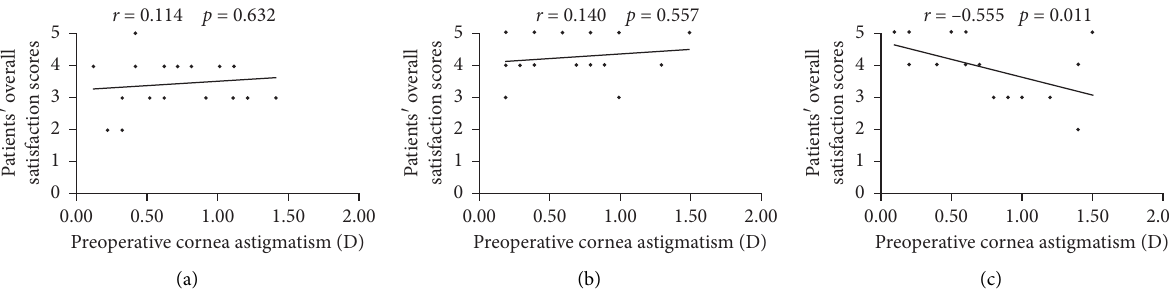
Figure 6: Correlations between the overall patient satisfaction score and preoperative corneal astigmatism in the 3 intraocular lens (IOL) groups. (a) Monofocal IOL group (Spearman’s correlation coefficient: r � 0 . 114, P � 0 . 632). (b) Extended range of vision (EDOF) IOL group (Spearman’s correlation coefficient: r � 0 . 140, P � 0 . 557). (c) Bifocal IOL group (Spearman’s correlation coefficient: r �− 0 . 555, P � 0 .